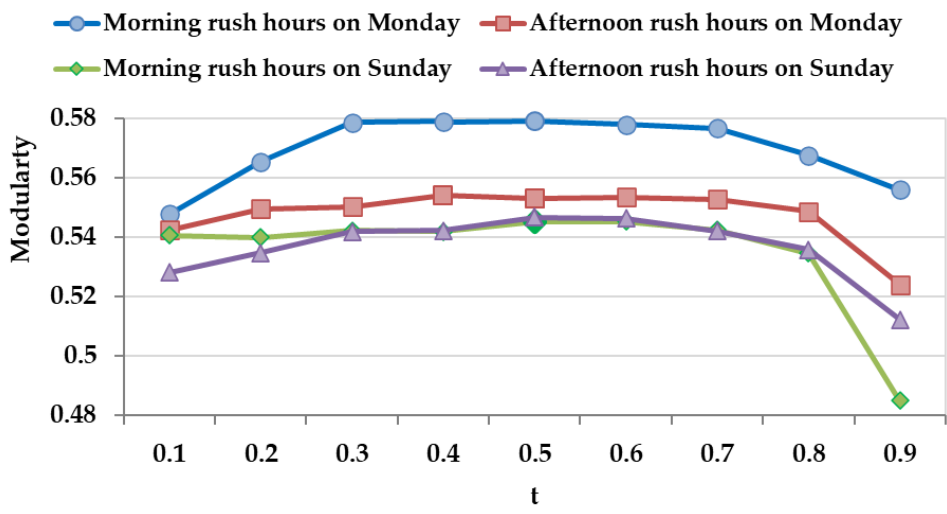
Figure 6. Modularity with the iteration number of global perturbations.